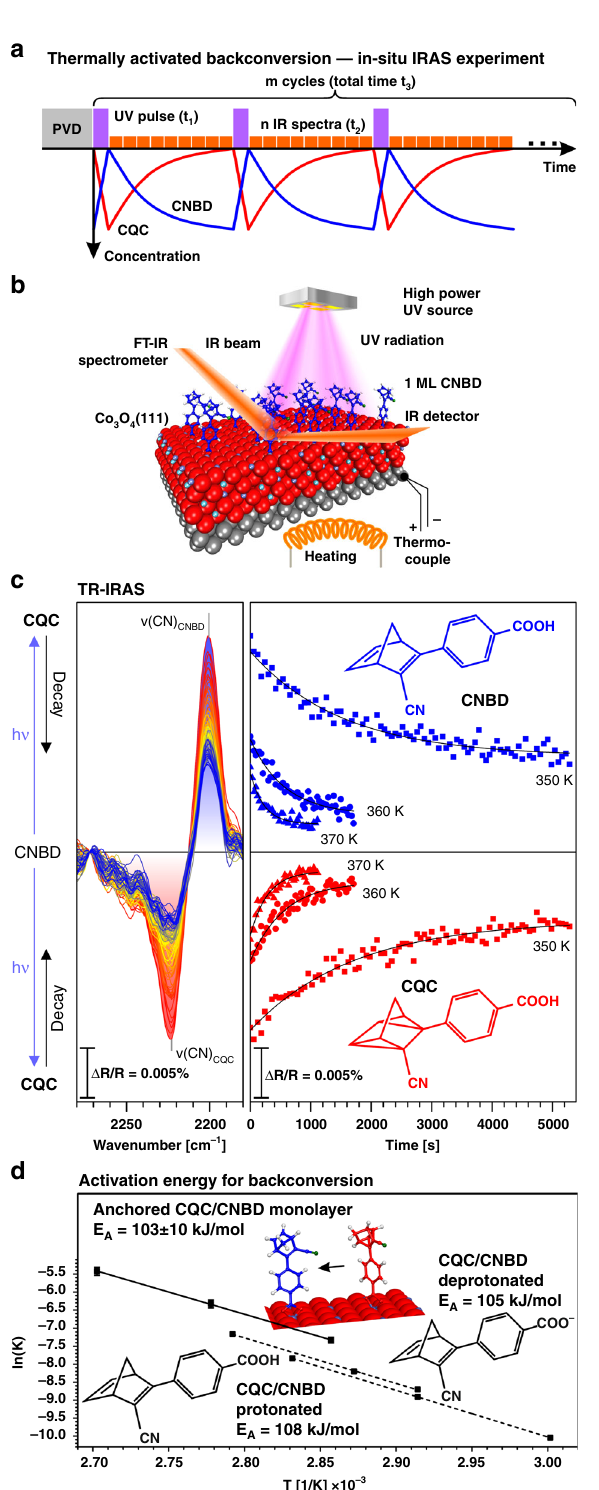
Fig. 4 Thermally activated backconversion of a CNBD monolayer on Co 3 O 4 (111): a the experimental procedure and ( b ) experimental setup used in the in-situ IRAS experiment; c spectra and intensities of the CN stretching bands of CNBD and CQC during photochemical conversion and thermally activated backconversion, referenced to the anchored CNBD monolayer (squares: 350 K, circles: 360 K, triangles: 370 K); d Arrhenius plot comparing the kinetic parameters for backconversion of the anchored CNBD monolayer and free CNBD in solution (protonated and deprotonated form) (anchored: connected by straight line, in solution: connected by dashed line)